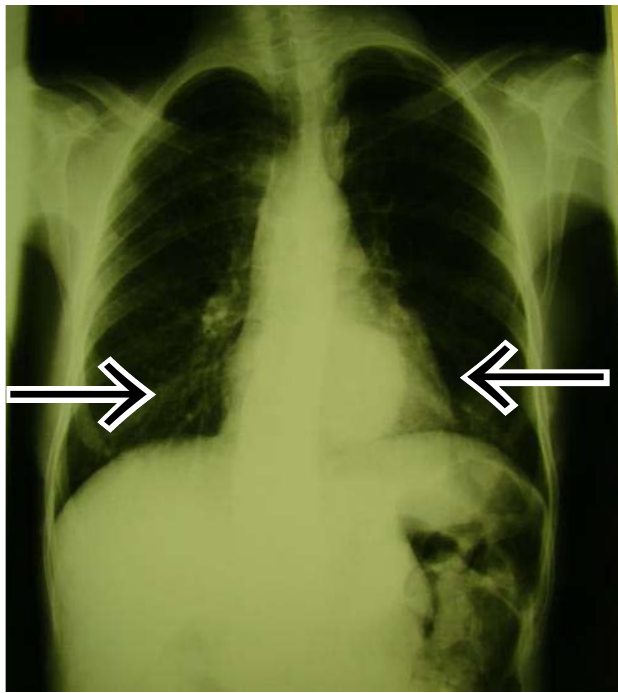
Fig. 12a. Frontal chest X-ray showing multiple cutaneous neurofibromas pro- jecting over the lung fields and a posterior mediastinal mass on the left.